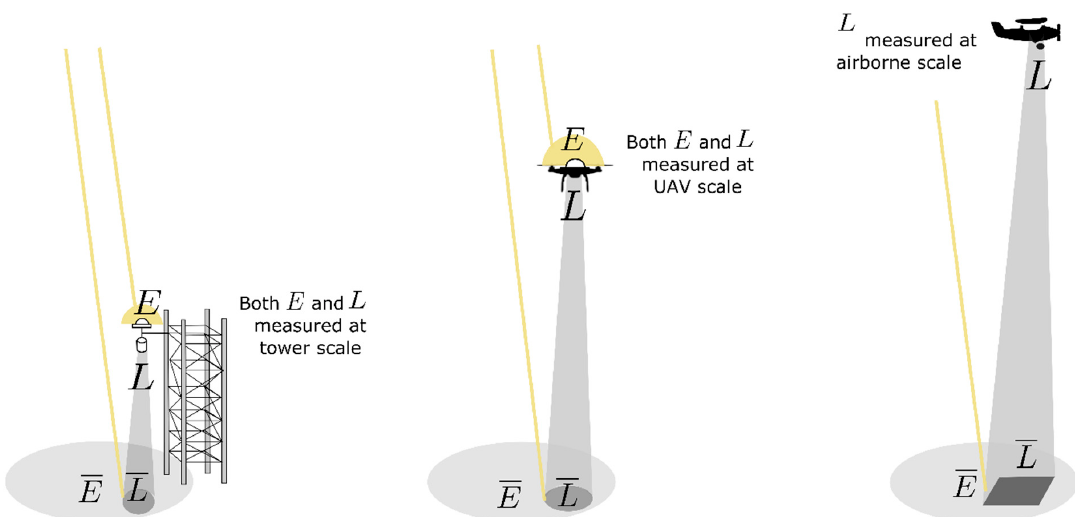
Figure 6. General system setups used to measure fluorescence at different vertical scales: tower, UAV, and airborne (from left to right). While the downwelling solar irradiance contribution is typically measured at the sensor level for systems mounted on towers and UAVs, at the airborne scale, only the upwelling canopy radiance is generally measured.